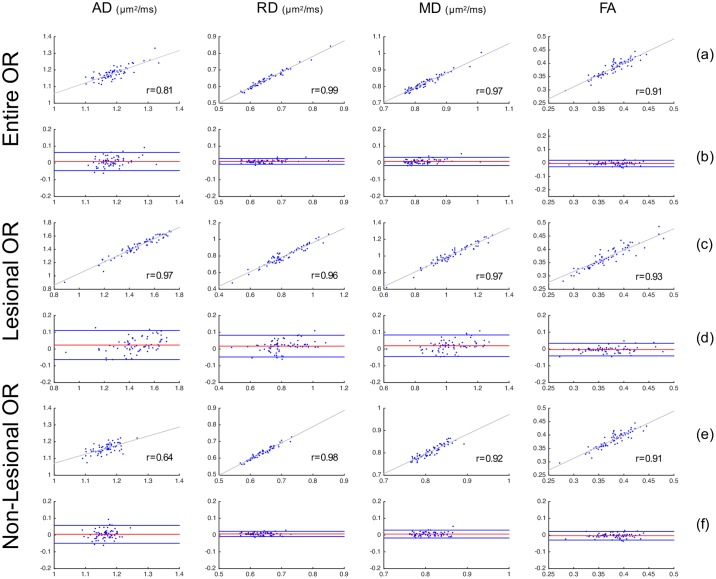
Comparison of OR diffusivity metrics between PT-OR and Template-OR approaches.Row (a), (c), (e) are scatter plots with linear fitting; x-axis is PT-OR measurement and y-axis is Template-OR measurement. r is the Pearson’s correlation coefficient. Row (b), (d), (f) are Bland-Altman plots for comparing two methods. x-axis is the mean of PT-OR and Template-OR measurements. y-axis is the difference between PT-OR and Template-OR measurements.